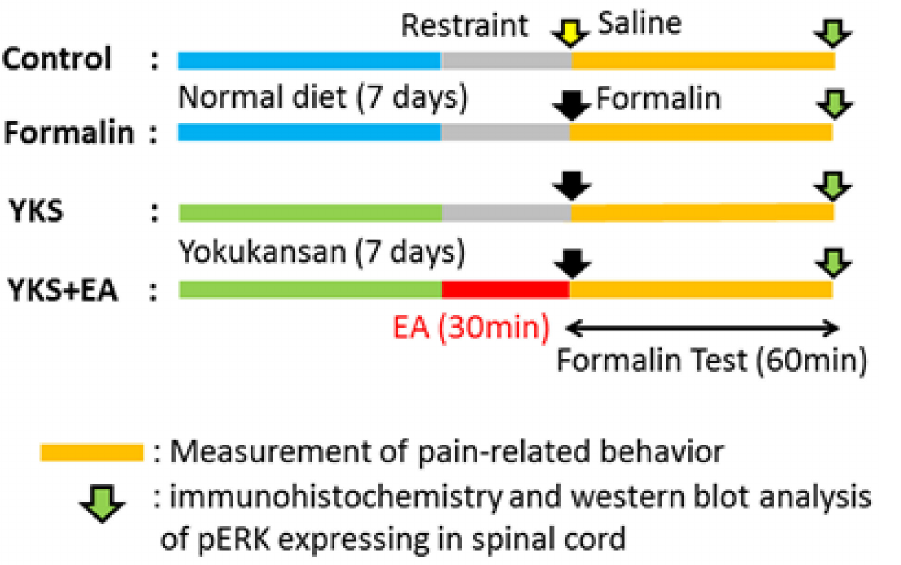
Figure 1. Experimental design of the study. Yokukansan (YKS) was mixed with powdered rodent chow at a concentration of 3% and was fed to the rats in the YKS and YKS + EA groups for 7 days. Electroacupuncture (EA) was performed at a frequency of 4 Hz for 30 min immediately before formalin injection in the YKS + EA group. The analgesic effects were determined using a formalin test (for 60 min), and then, spinal cord (L4–L5) samples for immunohistochemistry and western blot analysis were